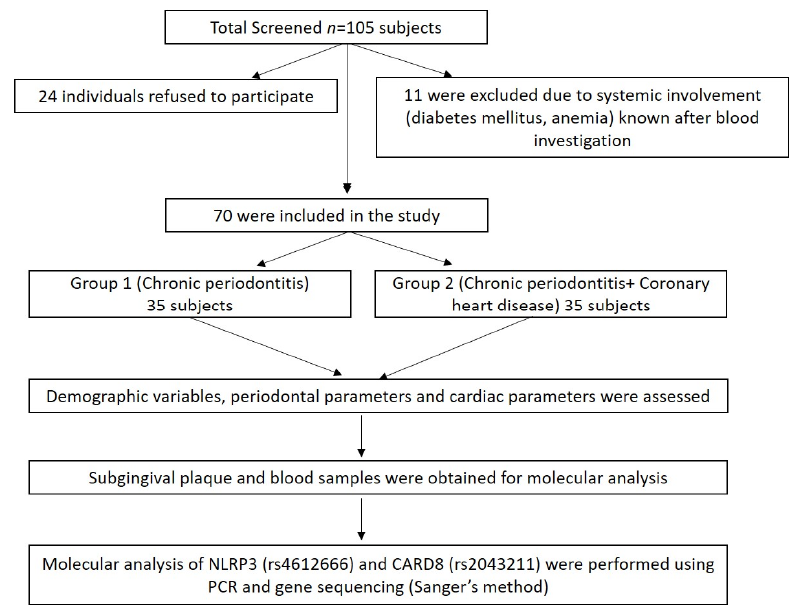
Figure 1. Summary of the s tudy design.